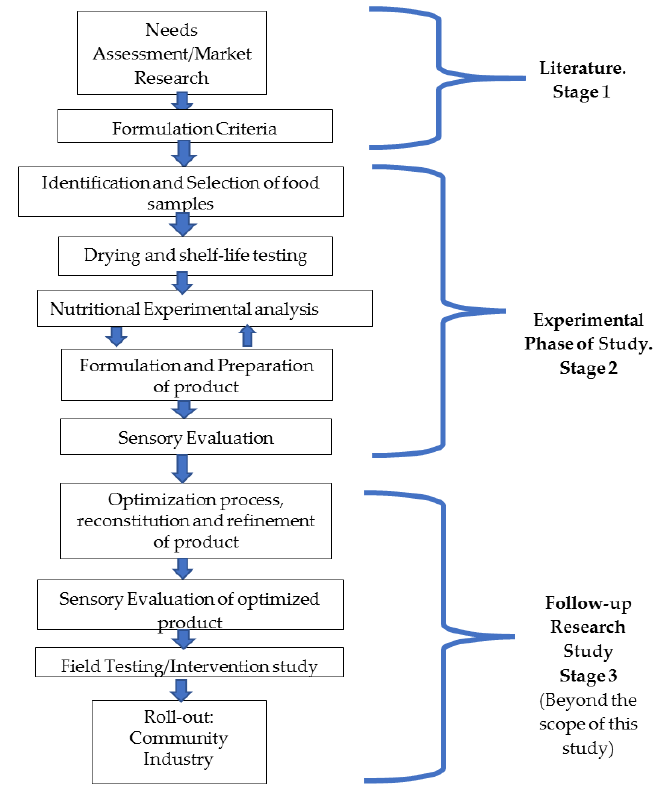
Figure 1. A schematic diagram showing the stages and processes involved in the development of complementary food (adapted from Zotor et al., 2015)